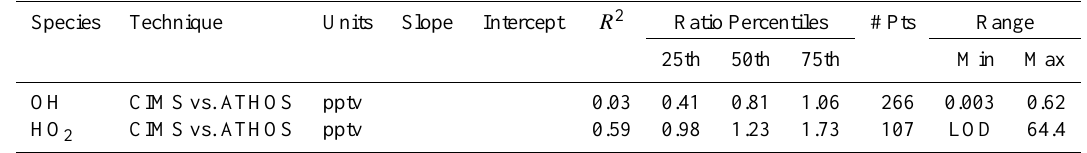
Table 3c. Statistical results of DC-8/C-130 intercomparison. Photochemical radicals. NOTE: Technique is listed as X (C-130) vs. Y (DC-8). Species